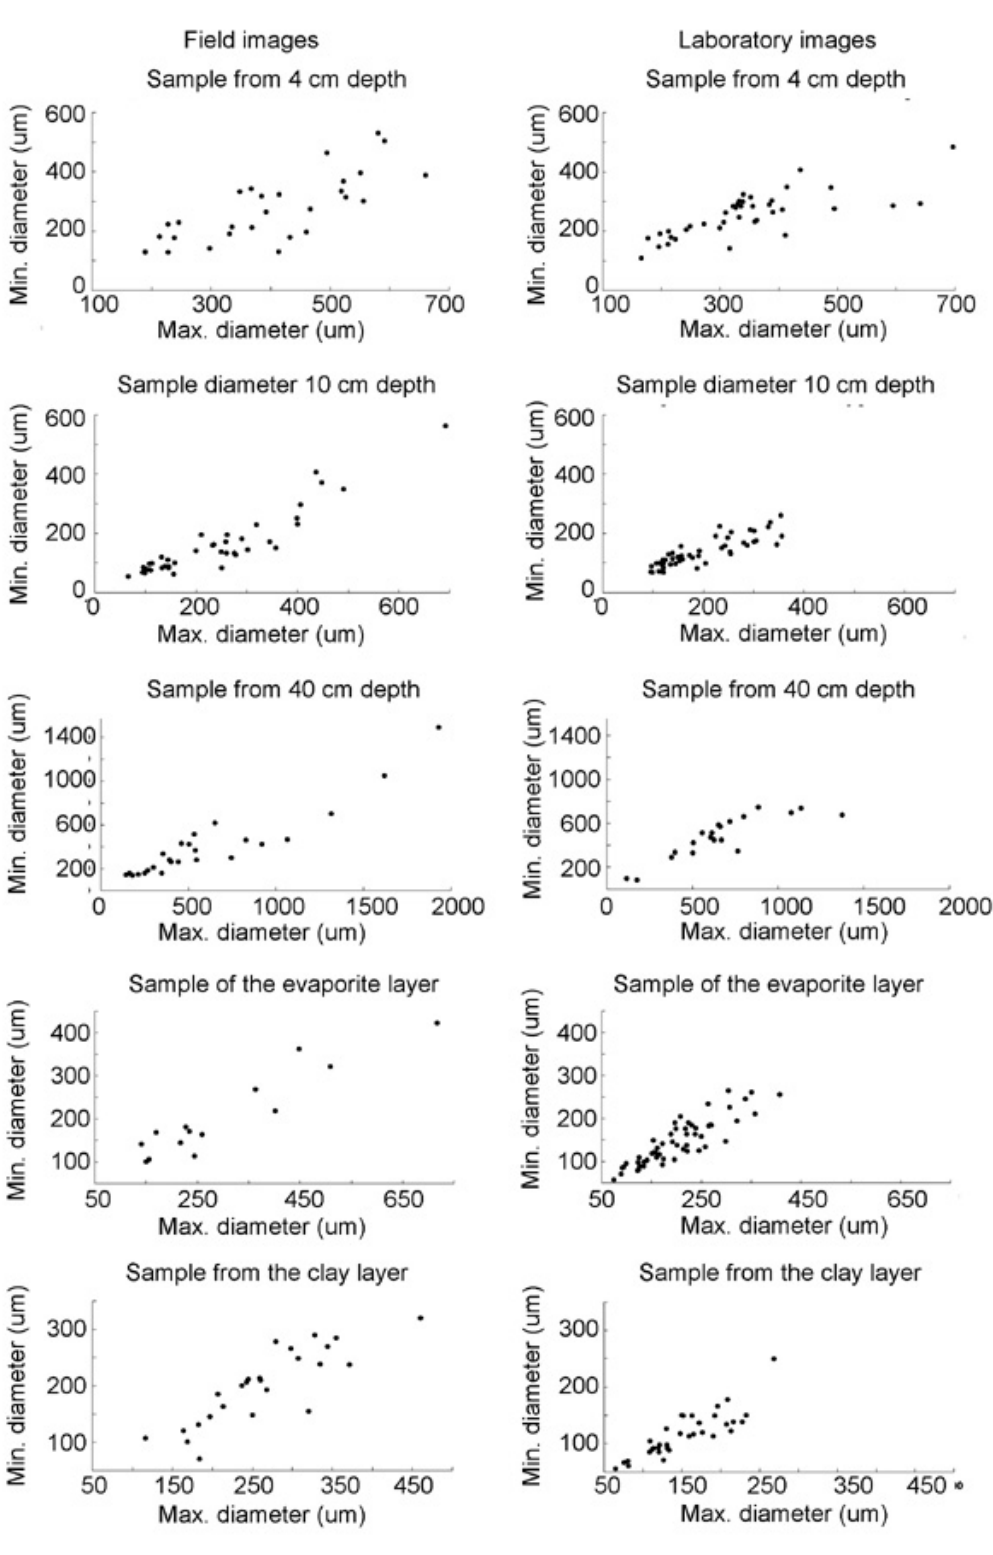
Figure 7. Diagrams of maximum/minimum diameter values of the grains from different depths based on field (left column) and laboratory (right column)